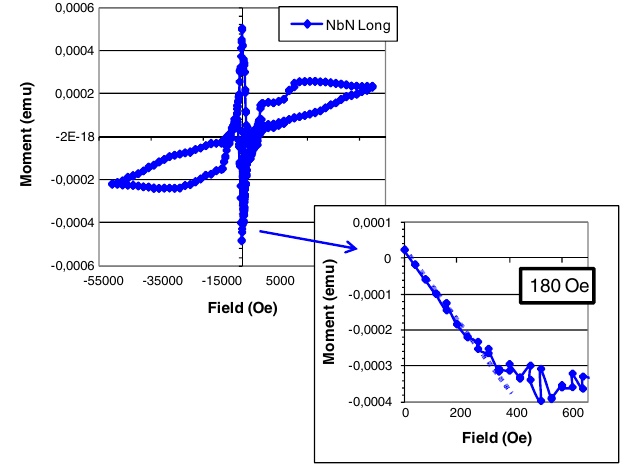
FIG. 5. Magnetization curves for a NbN sample ( (cid:5) 30 nm NbN directly deposited on sapphire): longitudinal moment. The inset shows the determination of the first penetration field B P .